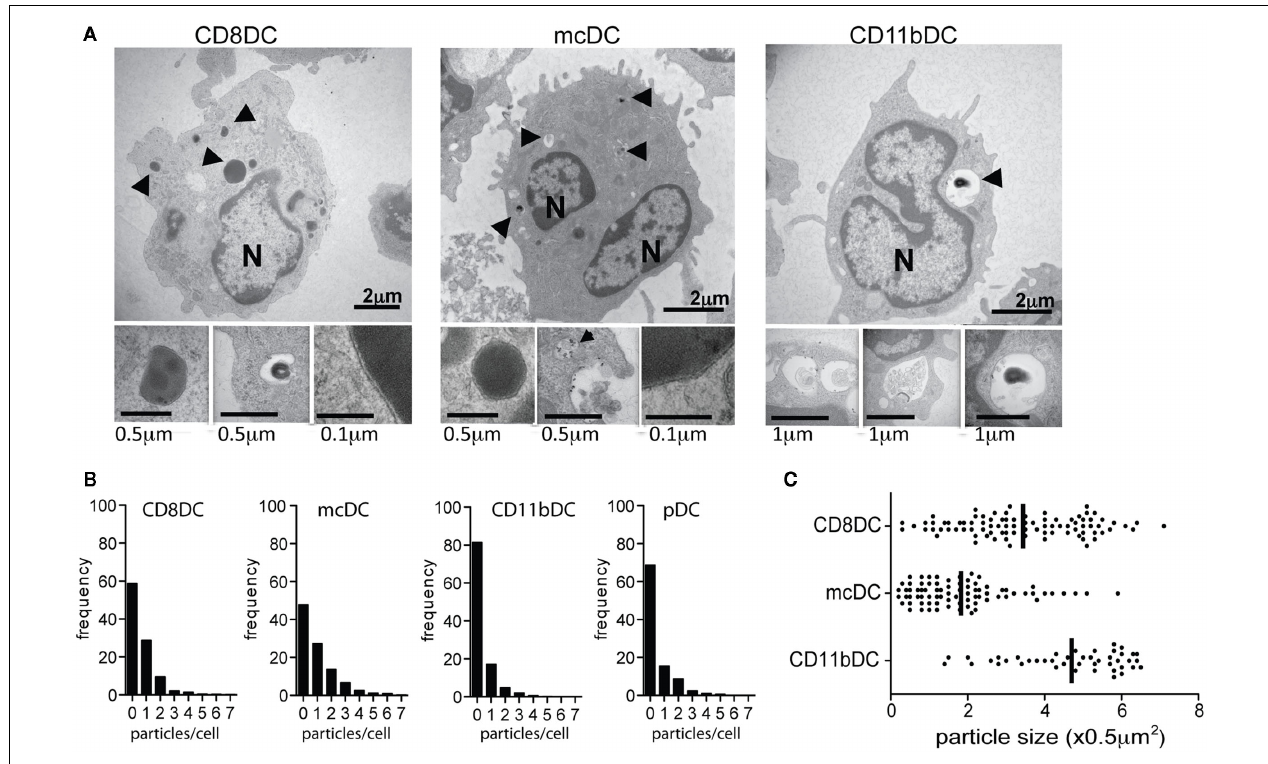
purified DC subsets after 4h co-culture: N, nucleus; arrows, apoptotic material. (B,C) ImageStream analysis of the frequency and size of internalized CFSE-labeled particles after 20h co-culture with CFSE-labeled irradiated